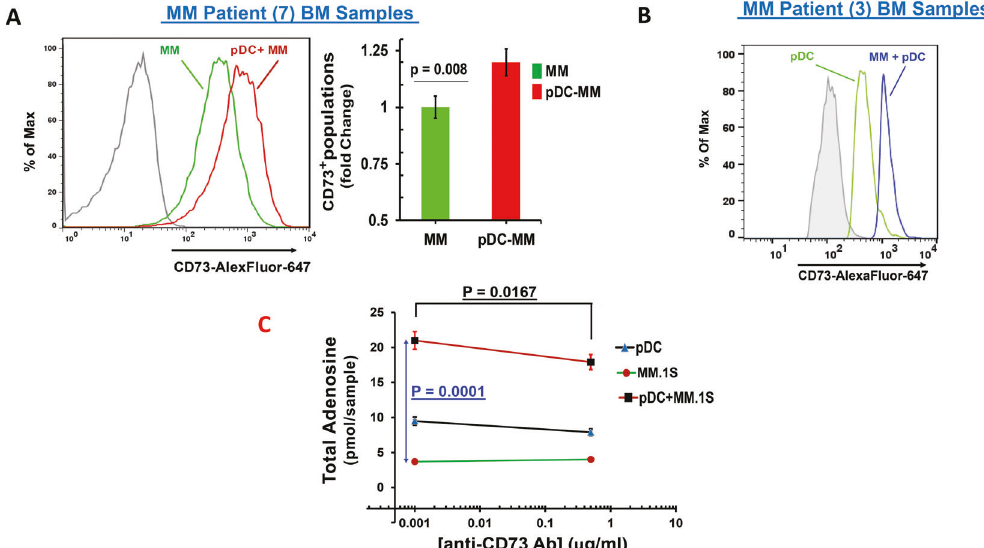
Fig. 3 Modulation of CD73 expression and adenosine levels during pDC-MM cell interactions. A pDCs were co-cultured with autologous patient MM cells for 24 h, followed by multicolor fl ow analyses to assess the pDC-induced change in CD73 expression on MM cells. CD138 + MM cells were examined using fl ow cytometry, and Median Fluorescence Intensity (MFI) of CD73 expression was determined using anti-CD73 Abs conjugated to AlexaFluor-488, in the presence or absence of pDCs. Left Panel: Representative histograms show CD73 expression in MM cells cultured in the presence (red) and absence (green) of pDCs. [Black histogram: Isotype control Ab]. Right panel: Normalized CD73 expression in MM cells cultured in the presence and absence of pDCs. Data were quanti fi ed from the histogram analyses shown in the left panel (mean ± SD; p = 0.008; MFI: 1.2-fold change in pDC-MM vs MM; Data obtained from analysis of seven MM patient BM samples). B pDCs were co-cultured with autologous patient MM cells for 24 h, followed by multicolor fl ow analyses to assess the changes in CD73 expression on CD303 + MM BM pDCs. Median Fluorescence Intensity (MFI) of CD73 expression was determined using anti-CD73 Abs conjugated to AlexaFluor-647. Representative histograms show CD73 expression in MM BM pDCs cultured in the presence (blue) or absence (green) of MM cells. (Shaded histogram: Isotype control Abs). C MM- BM pDCs were co-cultured with MM cells in the presence and absence of anti-CD73 Abs (0.5 µg/ml) for 2 days; supernatants were collected and analyzed for adenosine levels using a fl uorometric adenosine assay kit. The percentage of soluble adenosine in isotype-Ab- versus anti-CD73 Ab-treated MM cells, MM BM pDCs, both alone, or in pDC-MM coculture (mean ± SD, p < 0.05; n = 3) is shown. The quanti fi cation of data showing the amount of adenosine in supernatants (pmol/sample) for MM-pDC coculture versus MM cells alone ( p = 0.0167). (Note: The isotype treatment is indicated as a very low level of anti-CD73 Ab in the semi-log plot).